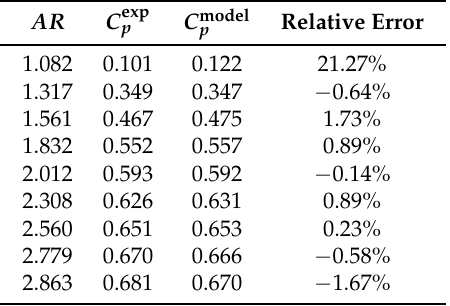
Table 5. Comparison of the model output with the experimental data from Kumar and Kumar